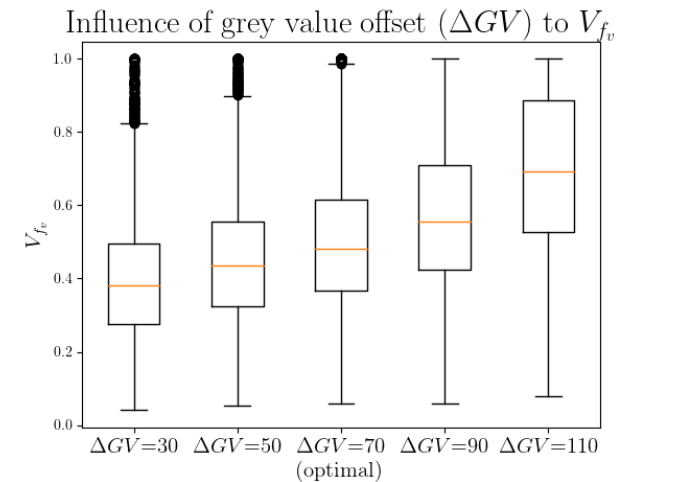
Figure 20. Grey value offset variation in relation to V f